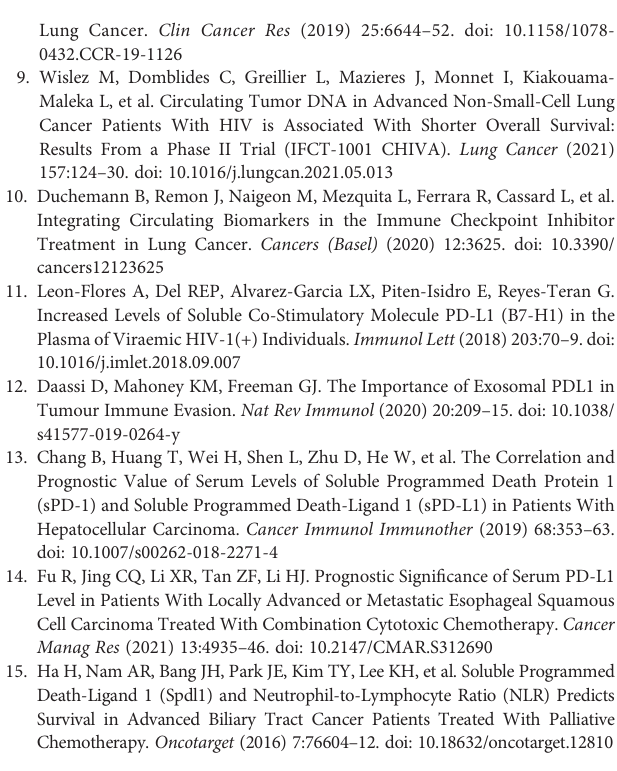
Supplementary Figure 1 | Sensitivity analysis by omitting every single study. Supplementary Figure 2 | Forest plot overall survival in regard to the baseline level of sPD-L1 in patients with non-small cell lung cancer receiving immune checkpoint inhibitors.